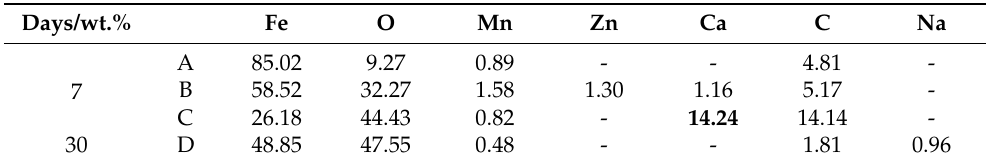
Figure 1. SEM images of carbon steel B450C exposed to SS1 cement extract solution after 7 days ( a ) and after 30 days ( b , c ). Table 7. EDS surface analysis (wt.%) of carbon steel B450C after exposure to SS1 cement extract solution for 7 and 30 days.